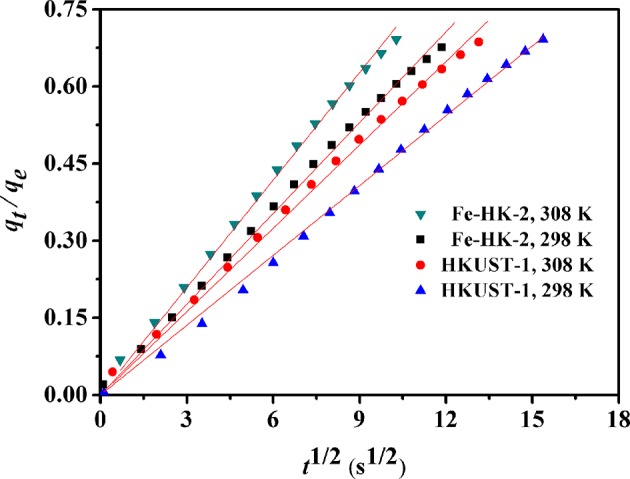
Plots of the fractional benzene uptakes (qt/qe) against the square root of adsorption time at 298 and 308 K.